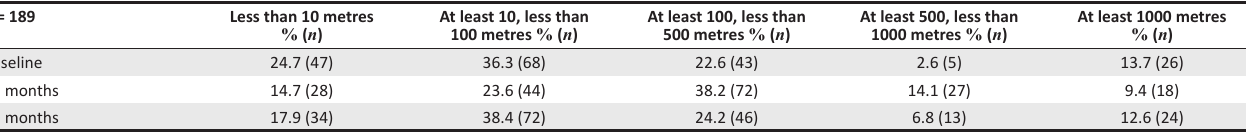
TABLE 6: Distance travelled over time. n =